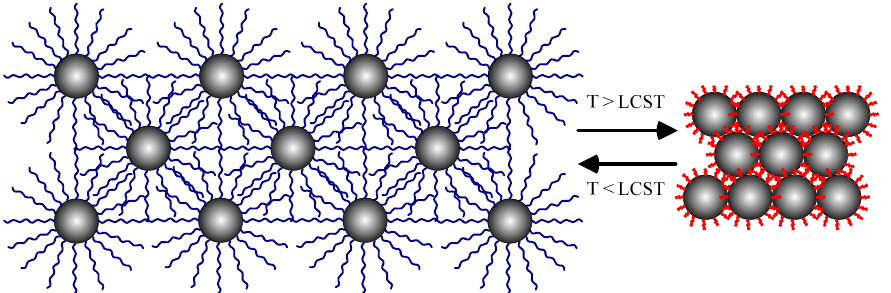
Figure 1. Cartoon representation of the SPMs array in aqueous layer, displaying a microdispersed state and 2D aggregated state below and above the LCST, respectively. Blue and red chains represent the extended and collapsed PNIPAM, respectively.